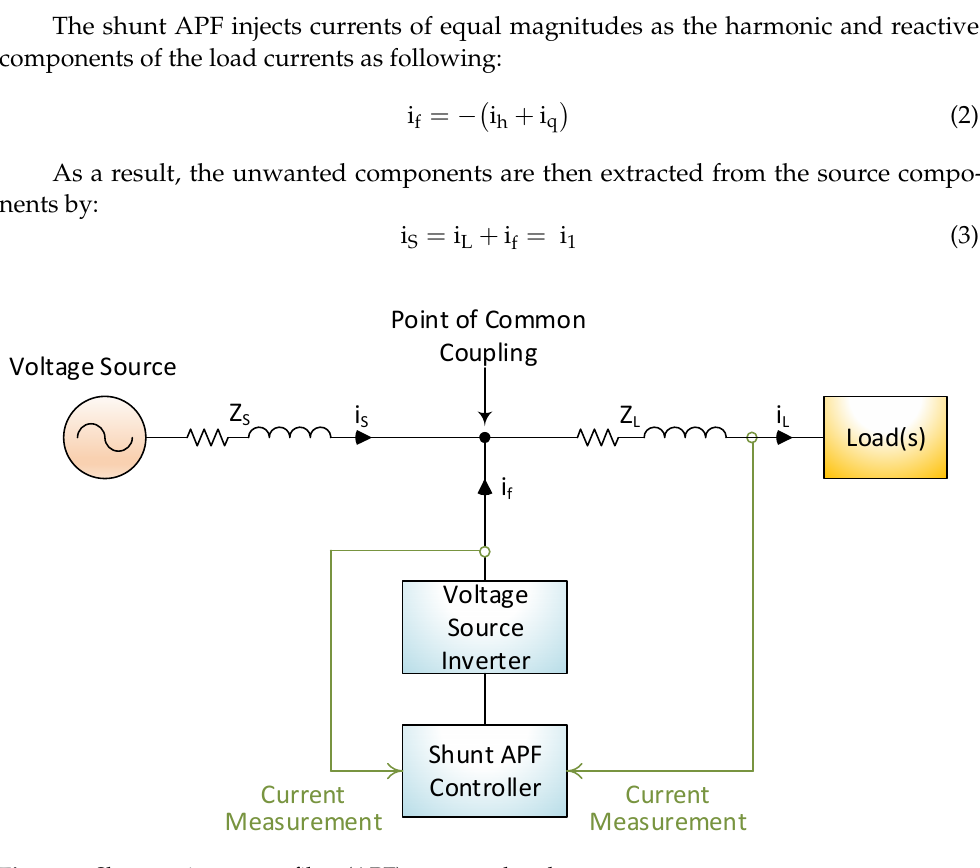
Figure 1. Shunt active power filter (APF) connected to the power system.